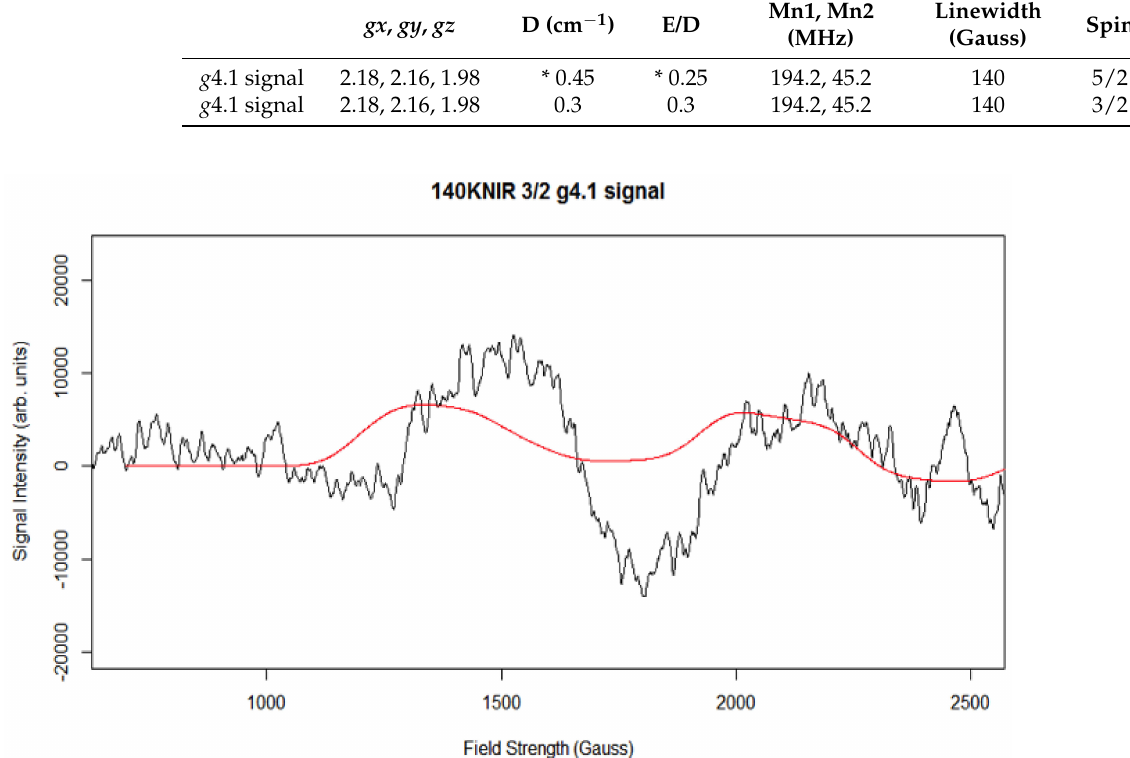
Figure 10. The experimental X-band CW-EPR difference g 4.1 spectrum and best-fit simulation (red spectrum). Spectrometer conditions: center field: 1650 G; frequency: 9.369115 GHz; microwave power 0.2 mW; sweep width: 2500 G; number of points 2500; number of scans: 5; temperature: 8 K; modulation amplitude 15 G (see Supplementary Materials